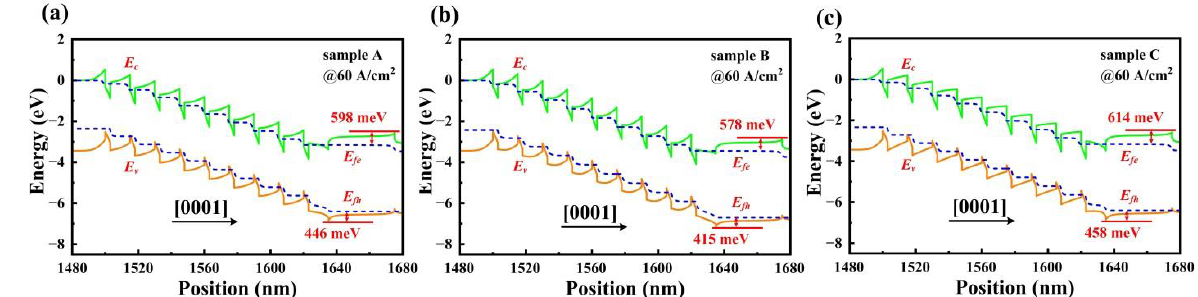
Figure 2. Energy band diagrams of ( a ) sample A, ( b ) sample B and ( c ) sample C near the MQWs region at current density of 60 A/cm 2 . E fe , E fh , E v and E c represent electron quasi-Fermi level, hole quasi-Fermi level, valence band and conduction band, respectively.